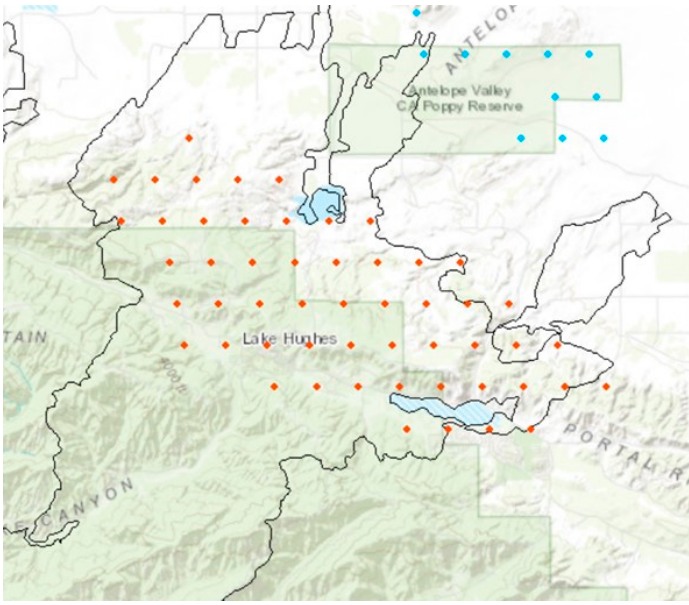
Figure 4. Boundary map of the Powerhouse Fire (2013; solid line) near Antelope Valley, CA, showing positive breakpoints (in orange) and showing negative breakpoints for 2013 (in blue). Map is upward in the northern direction.